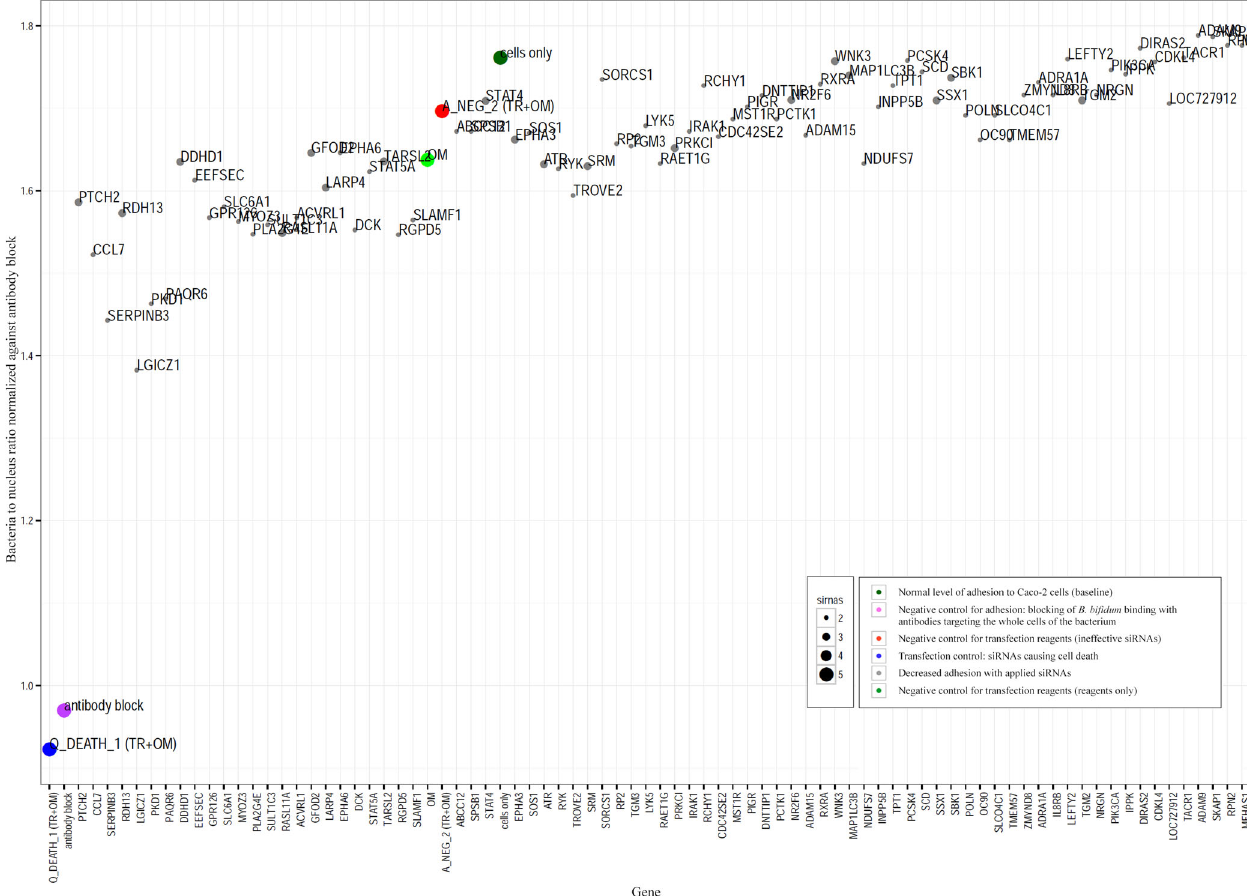
Fig. 4 Results of the validation siRNA screen. The normal baseline adhesion without any siRNAs is indicated as dark green. Decreased adhesion with speci fi c siRNAs is indicated with grey. Dark purple dots indicate the control samples in which the bacterial surface proteins were blocked with the antiserum produced against whole B. bi fi dum cells. The samples with ineffective siRNAs (to test the effect of transfection reagents) are indicated with red and light green dots and the samples with death siRNAs (transfection ef fi ciency controls) are indicated as bright blue dots. Y axis presents bacteria to nucleus ratio normalized against antibody block control and gene abbreviations are given on X